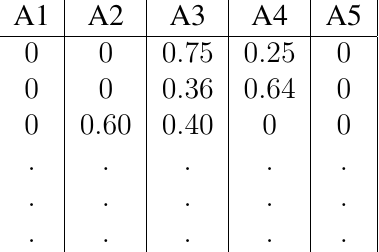
Table 2: An example of fuzzy coding of a continuous variable into a fuzzy indi- cator variable with five